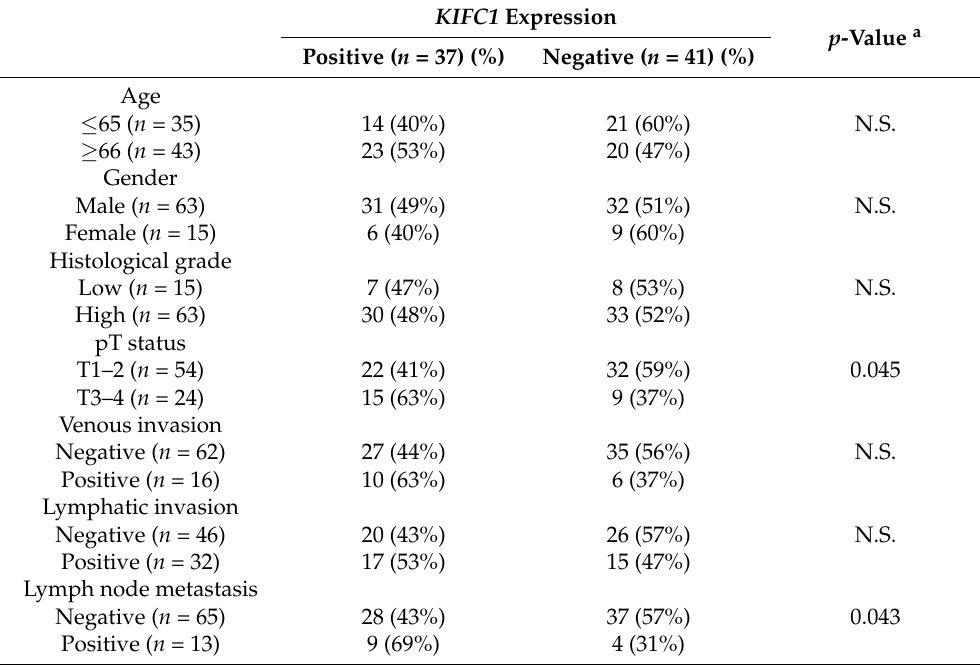
Table 1. Relationship between KIFC1 expression and clinicopathologic characteristics in the 78 blad- der cancer from Hiroshima